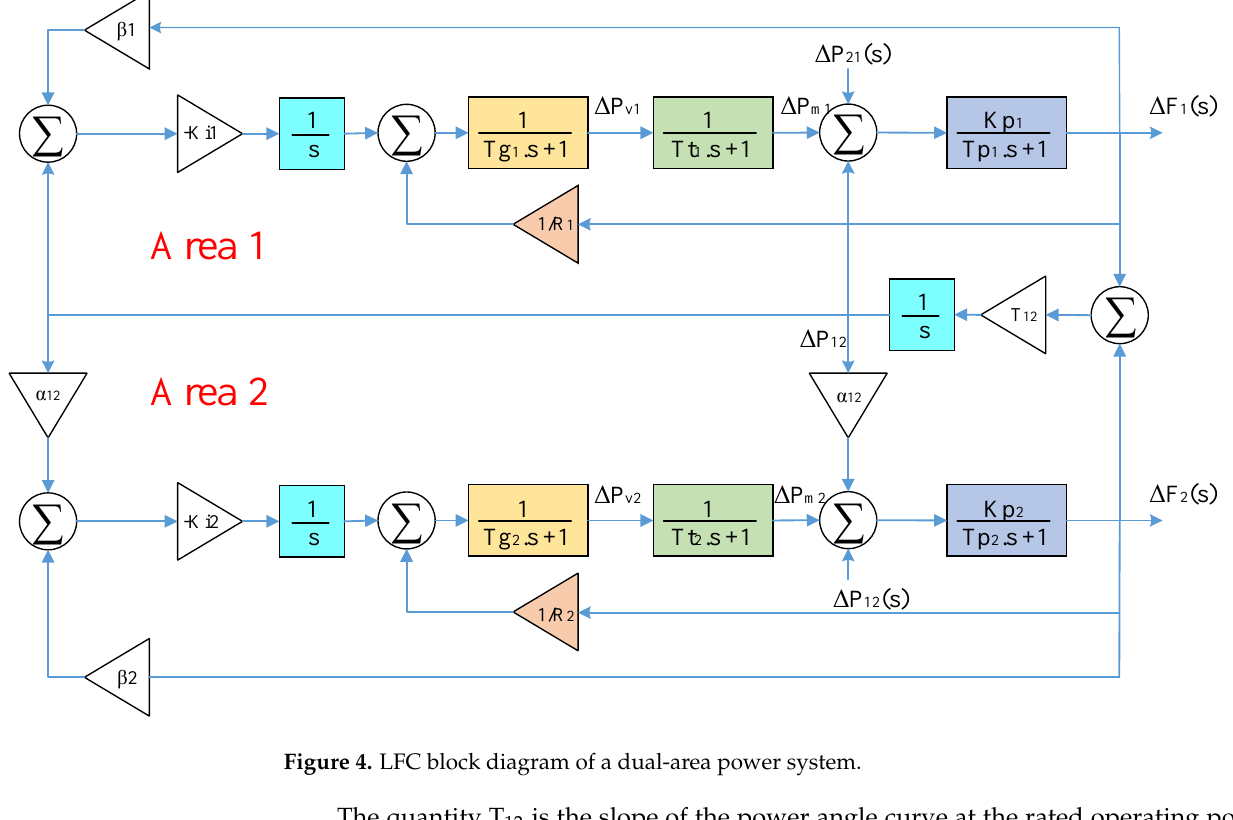
Figure 3. Two-area power system.